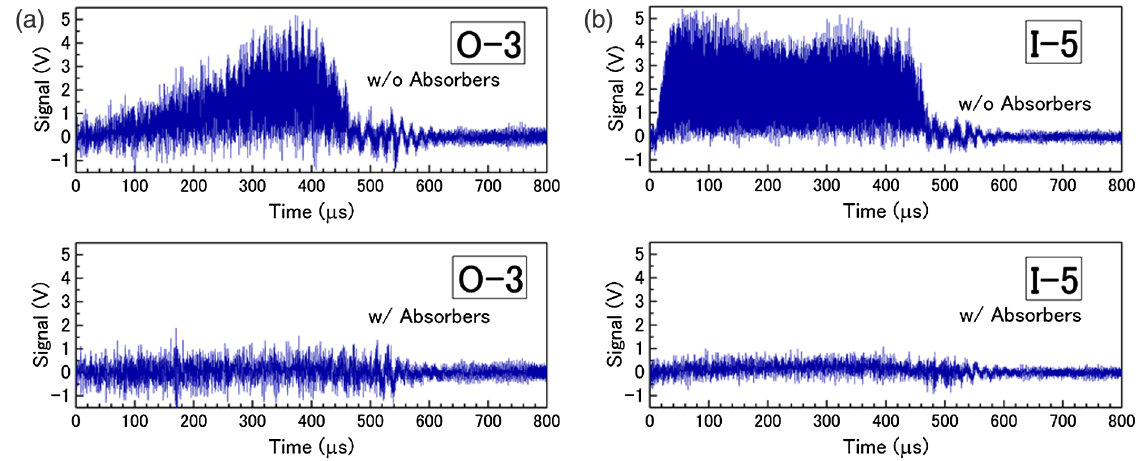
FIG. 13. BLM signal during the injection period at (a) O-3 and (b) I-5. The horizontal axis represents time, and the vertical axis represents the signal amplitude. Upper: extracting the absorbers. Lower: inserting the